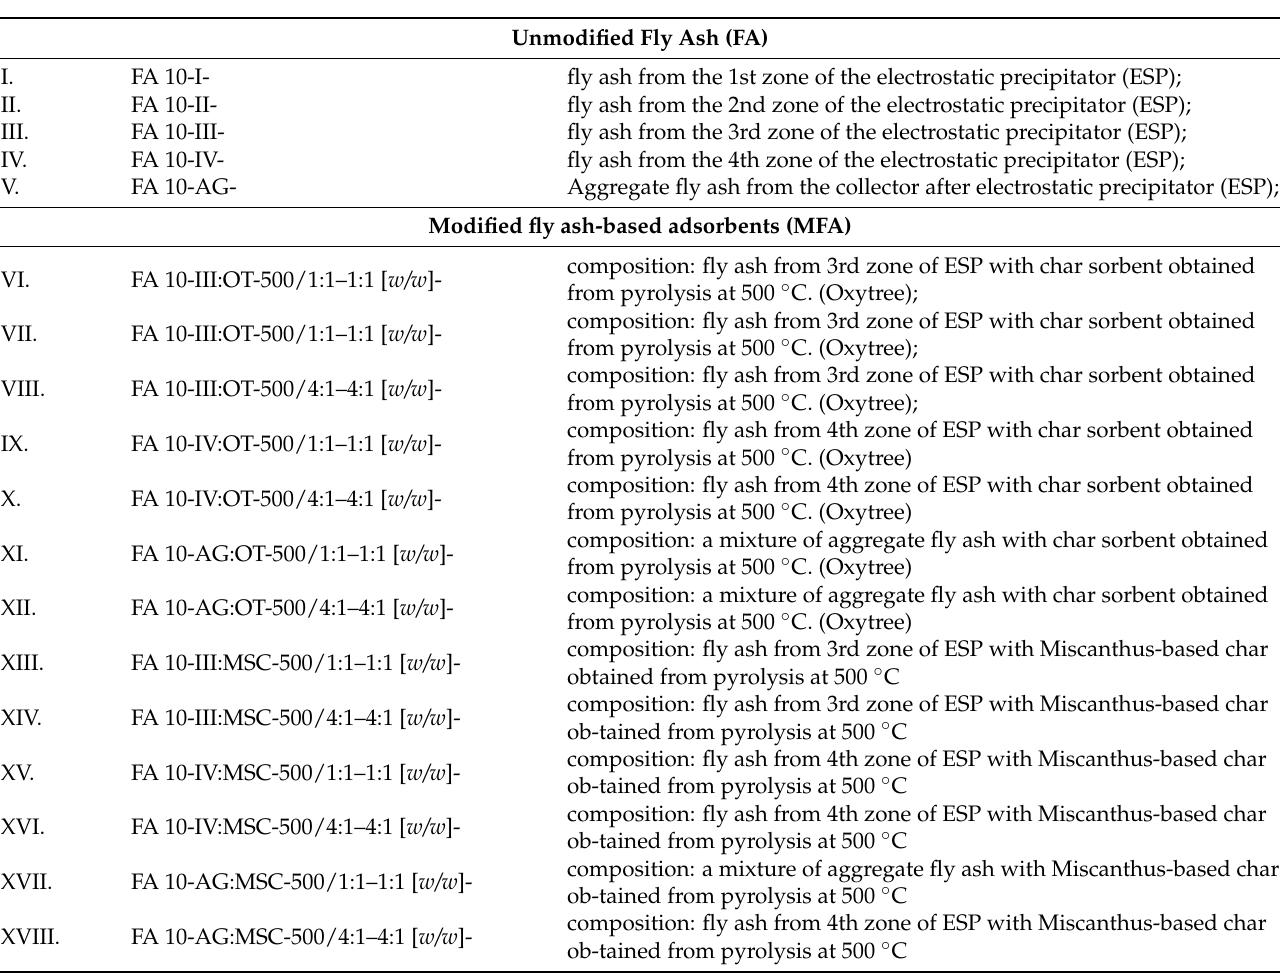
Table 1. Characteristics of the analyzed